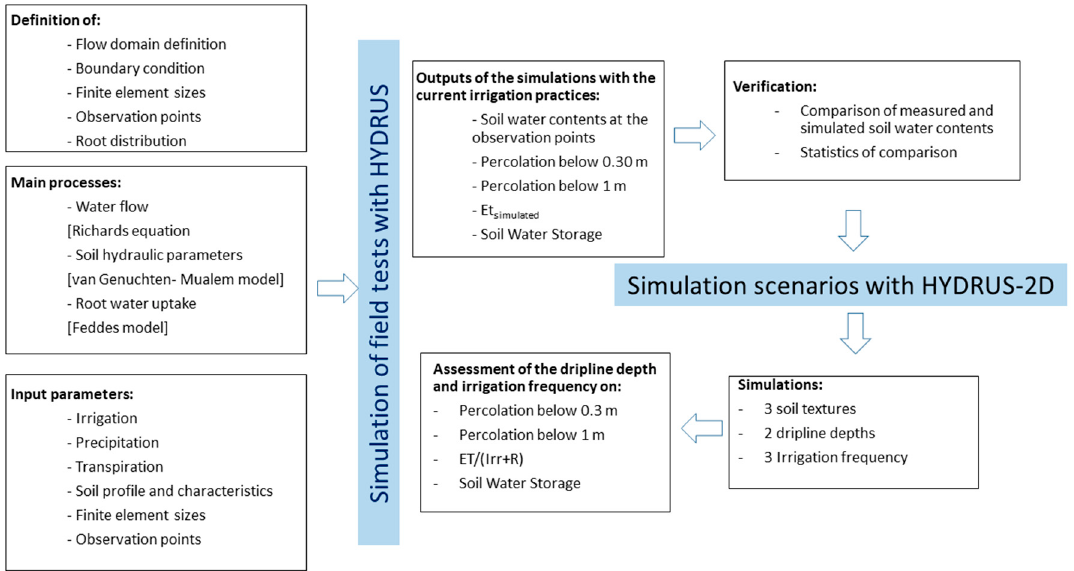
Figure 2. Conceptual model showing input and output parameters and followed procedure for the set of simulations carried out.